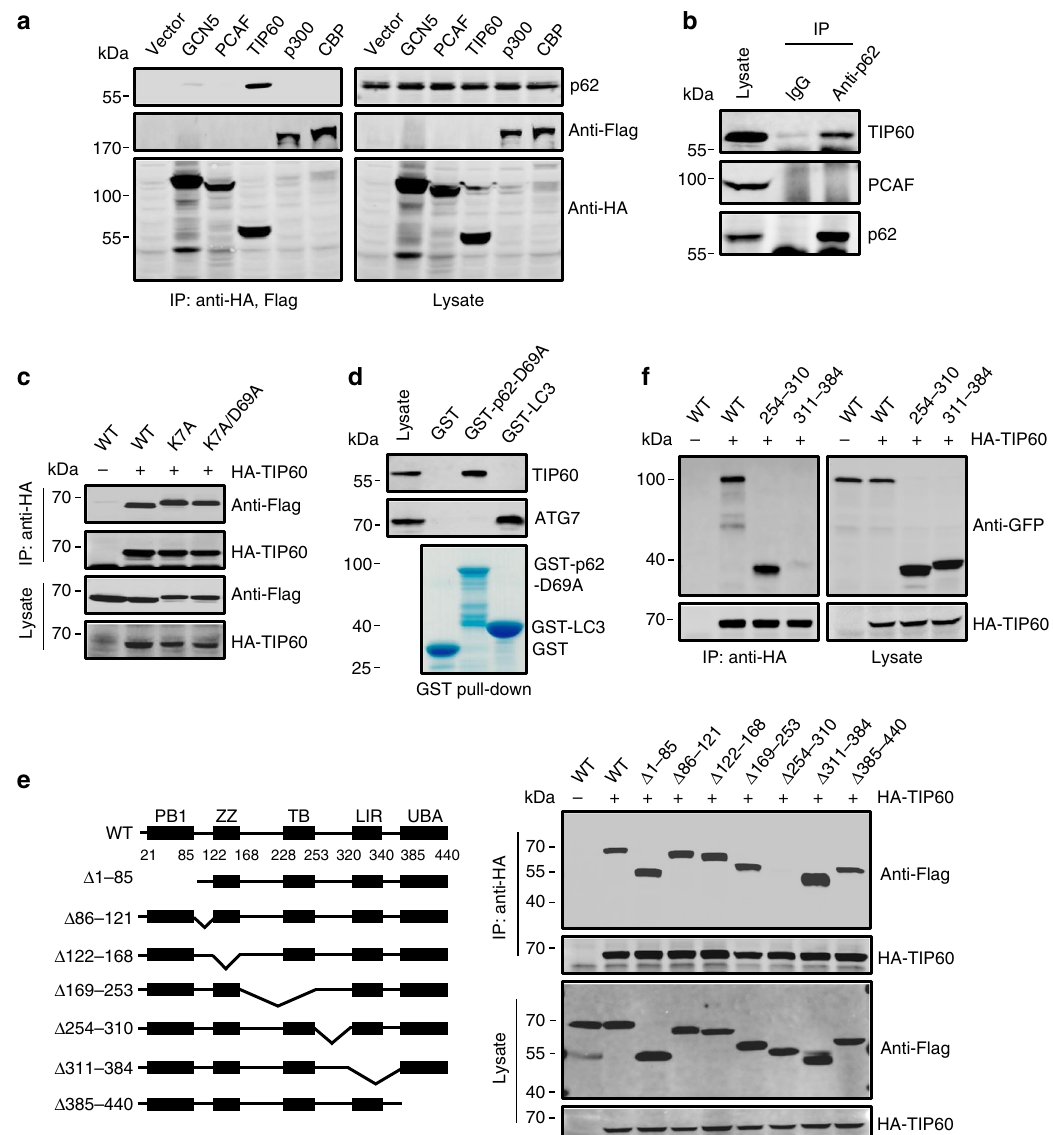
Fig. 2 Interaction of p62 and TIP60. a Co-immunoprecipitation of endogenous p62 with exogenously expressed acetyltransferases from HEK293T cells. Acetyltransferases were immunoprecipitated by anti-HA or anti-Flag and the precipitates were analyzed using anti-p62. b Co-precipitation of endogenous TIP60 with p62 from HEK293T cells. c Co-immunoprecipitation of p62 mutants with HA-TIP60 in HEK293T cells. HA-TIP60 was immunoprecipitated by anti-HA and the precipitates were analyzed using anti-Flag. d HEK293T cell lysates were incubated with puri fi ed GST-p62-D69A or GST-LC3B, and bound TIP60 and ATG7 were detected by western blot using anti-TIP60 and anti-ATG7. e , f Co-precipitation of Flag-tagged ( e ) or GFP-tagged ( f ) p62 truncated mutants with HA-TIP60 from HEK293T cells. HA-TIP60 precipitates were analyzed using anti-Flag and anti-GFP, respectively. Source data are provided as Source Data fi